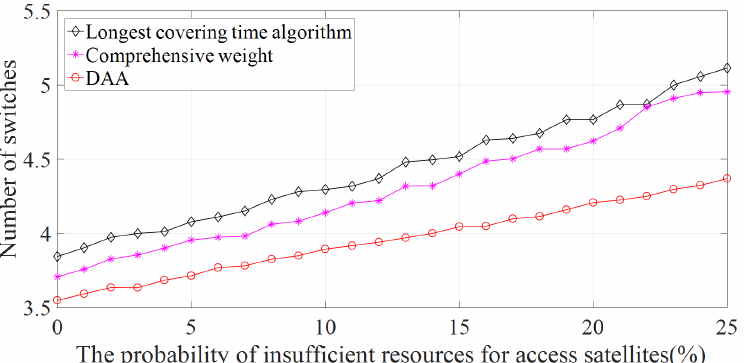
Figure 11. Relationship between the probability of insufficient resources for access satellites and switching